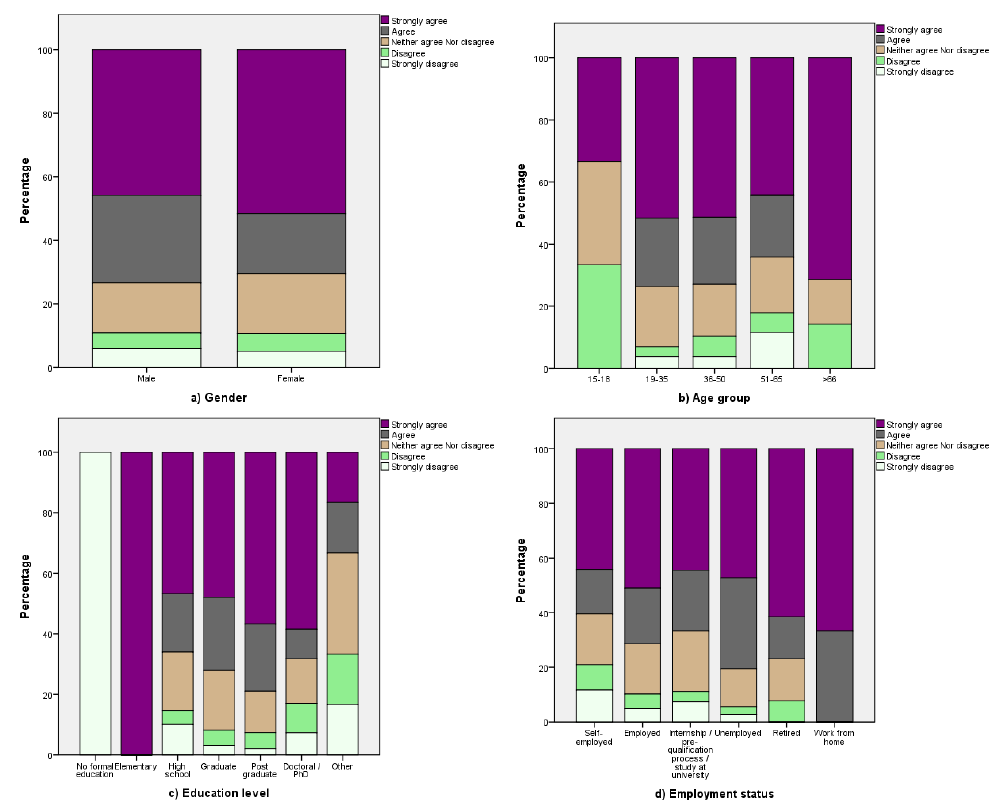
Figure 2. Satisfaction of participants on the current walk-in method by a) Gender, b) Age group, c) Education level, and d) Employment